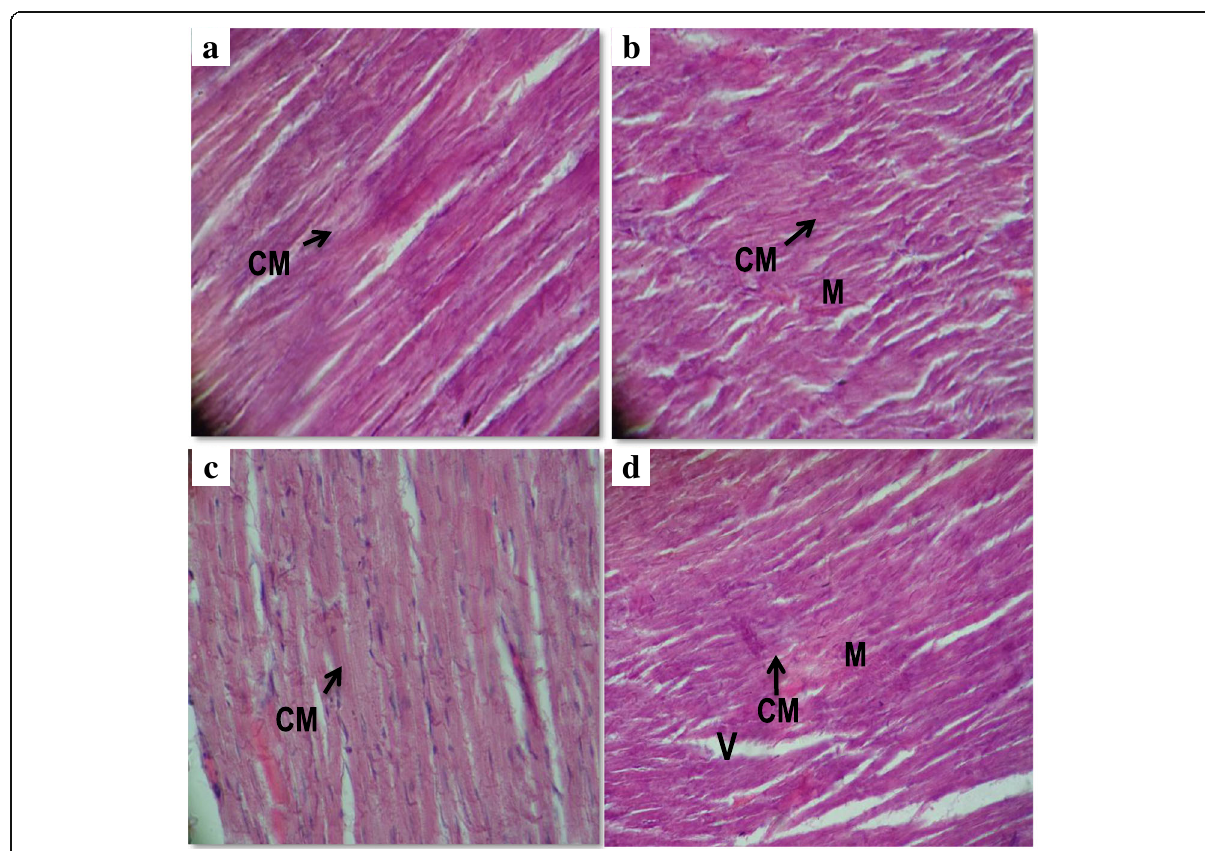
Fig. 4 Heart histological sections of rats in sub-acute toxicity study. a Normal control group; b 10 mg/kg BA-treated group; c 10 mg/kg UA- treated group; d 50 mg/kg APAP-treated group (× 25, H&E stained). CM — cardiac muscle, M — myocytes, V —